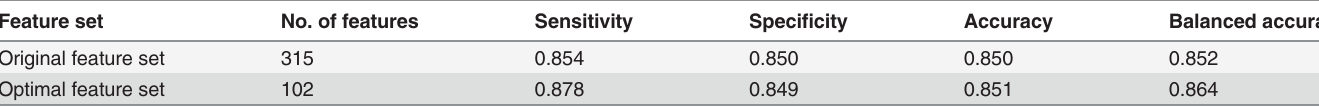
Table 2. Prediction results of the original feature set and the optimal feature